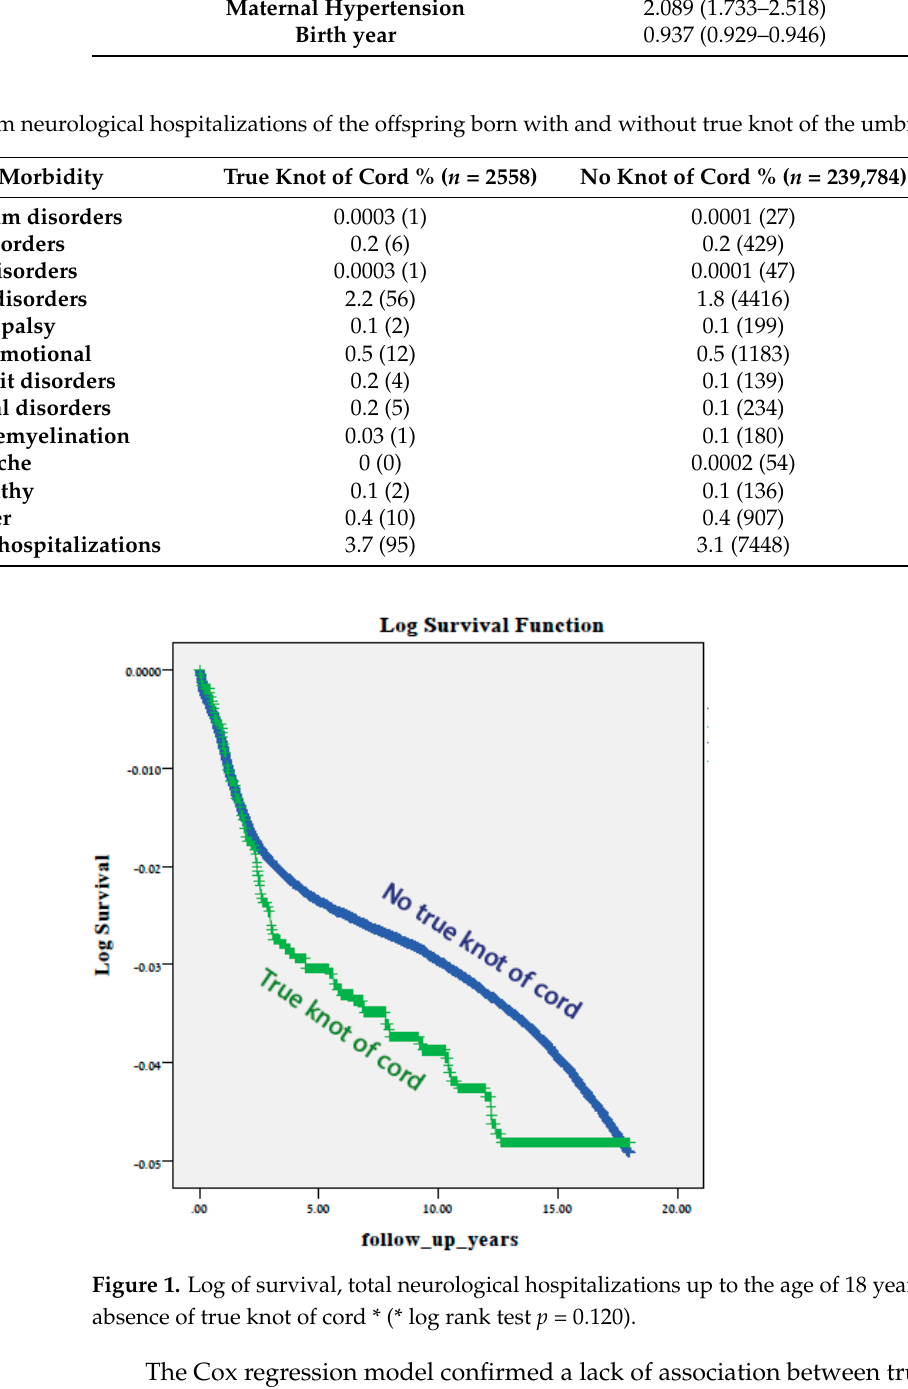
Table 1. Perinatal outcome according to presence or absence of true knot of the umbilical cord. Perinatal Outcomes